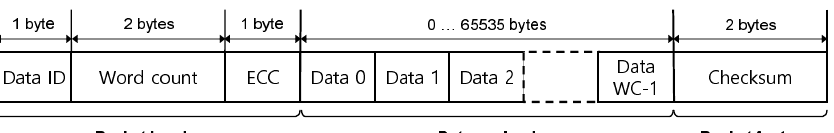
Figure 1. A short- and a long-packet structure [4].